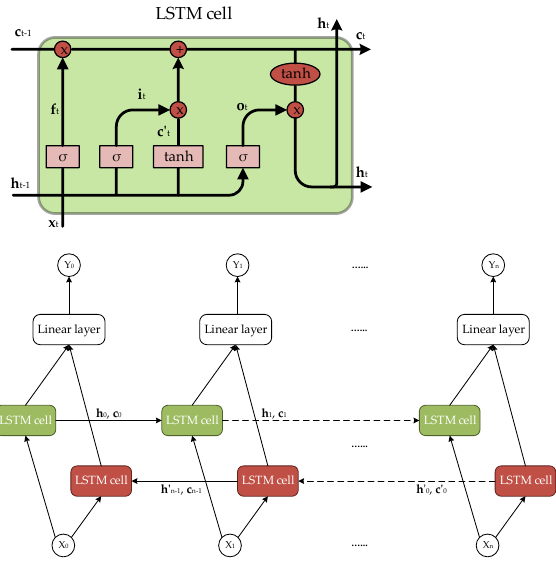
Figure 8. The structure of an LSTM cell ( top ) and the structure of the proposed bi-LSTM approach ( bottom